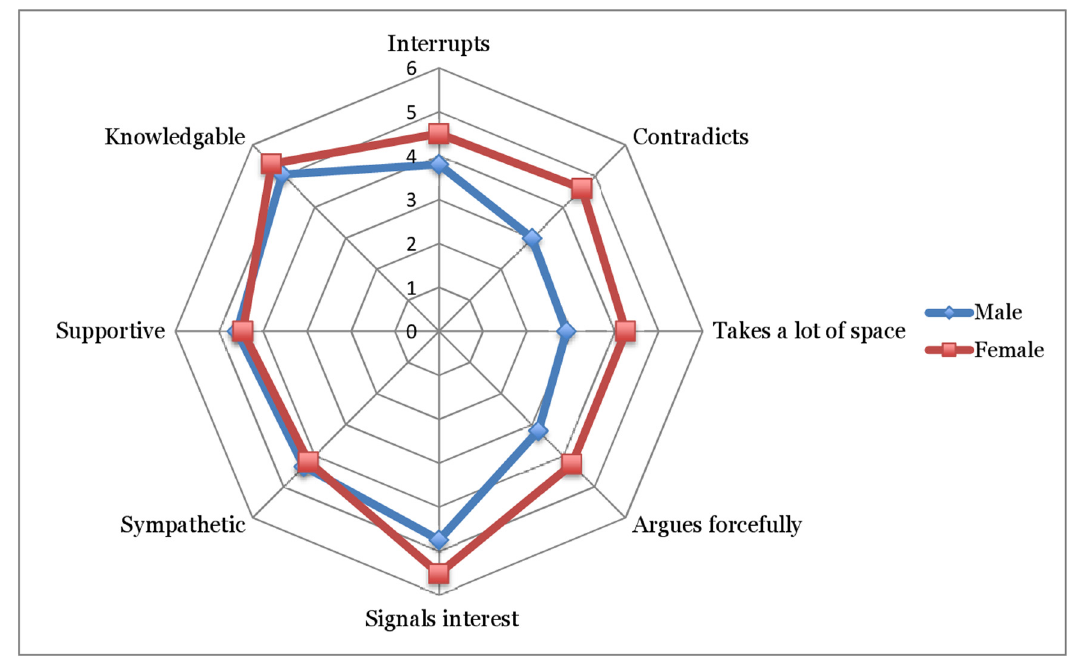
Figure 4: Response patterns to male and female manipulations, Seychelles respondents ( n = 97 ) . The red bars represent average responses on a 7 - point Likert scale to the female manipulation while blue represents responses to the male